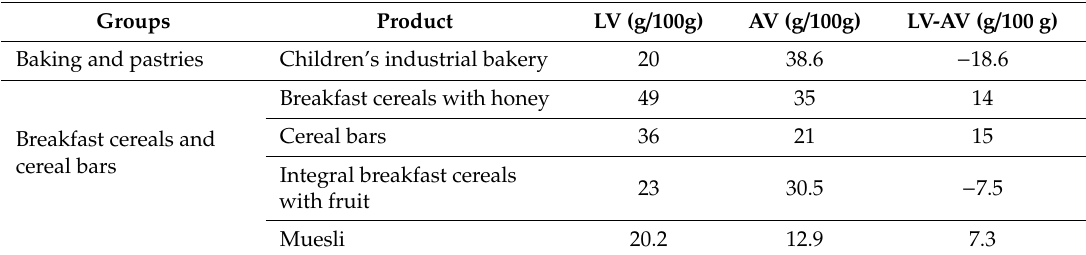
Table 4. Individual label values (LVs) and analytical values (AVs) of the products that did not meet EU tolerance